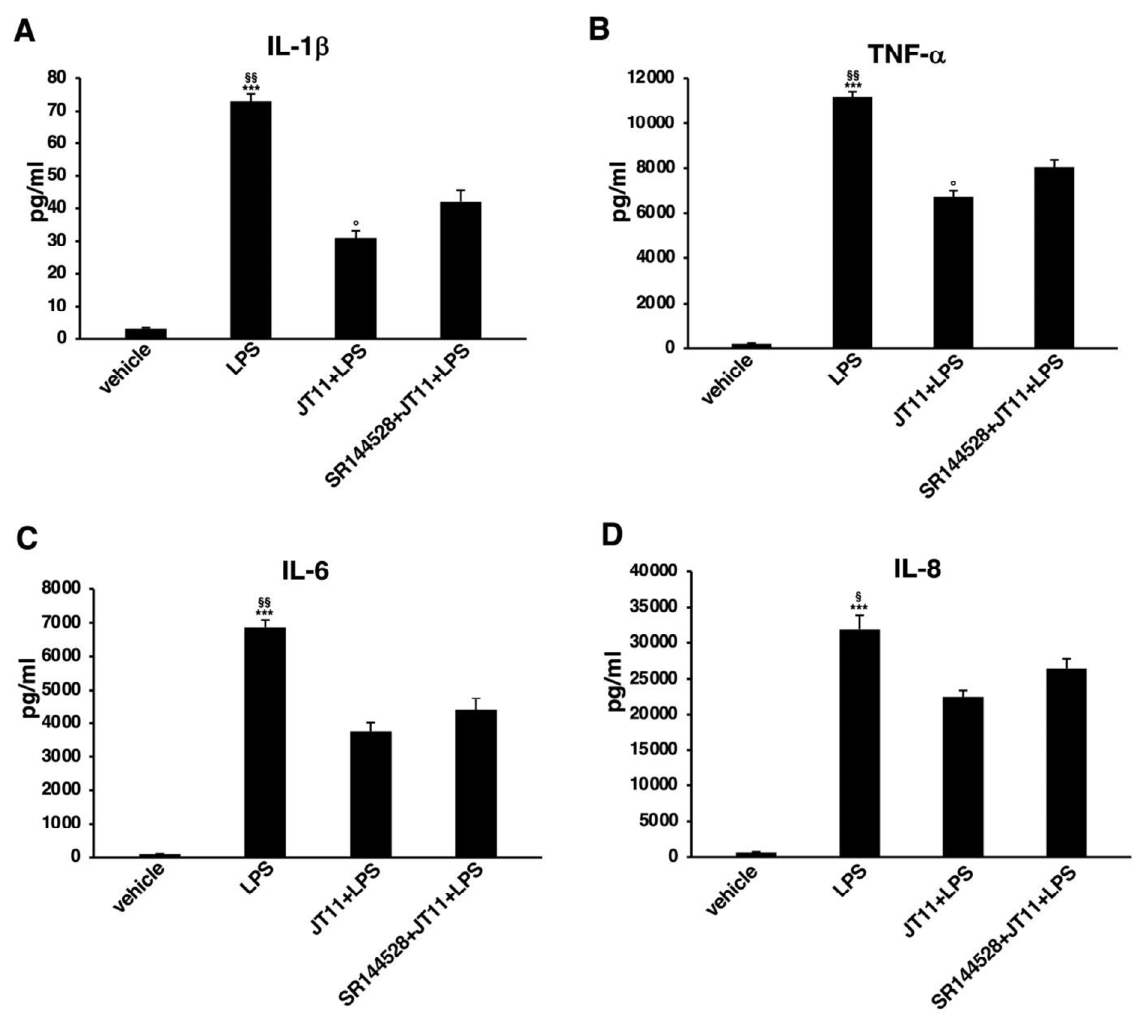
Figure 6. JT11 reduces LPS-induced release of pro-inflammatory cytokines in human PBMCs. PBMCs from healthy donors were pretreated for one hour with 2 μ M JT11 and stimulated for 24 h with 100 ng/mL LPS. Alternatively, PBMCs were analyzed in the presence of selective CB2R antagonist SR144528 (1 μ M). The culture medium was separated by centrifugation, and the concentration of cytokines interleukin (IL)-1 β ( A ), tumor necrosis factor (TNF)- α ( B ), IL-6 ( C ) and IL-8 ( D ) was measured with an immunoassay using Luminex ® xMAP ® technology. Data are reported as mean ± SD of three independent experiments performed in duplicate. *** p < 0.0001 vs. vehicle; § p < 0.01 vs. JT11 + LPS; §§ p < 0.001 vs. JT11 + LPS; ° p < 0.01 vs. SR144528 + JT11 + LPS.